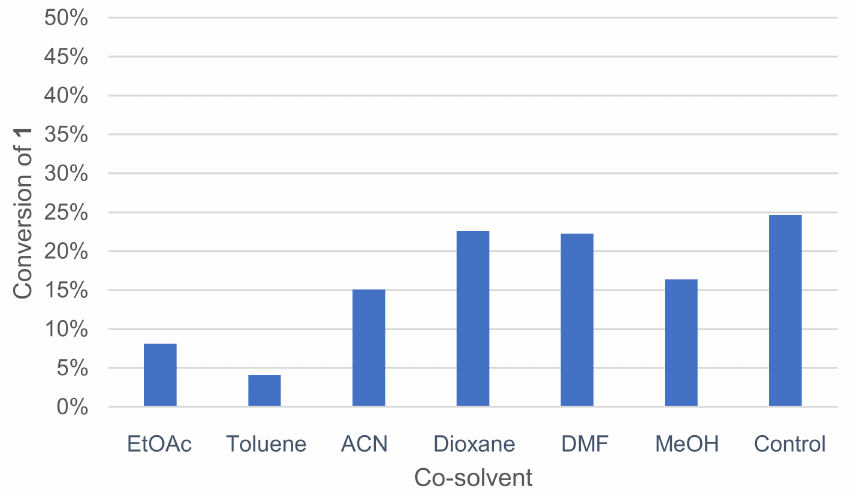
Figure 4. Effect of co-solvents on the conversion of 1 in the laccase-catalyzed oxidation (LA 10% w/w , HOBt 20 mol%, acetate buffer pH5 0.25 M, co-solvent 50% v/v buffer , O 2 atmosphere, incubation for 24 h, 40 ◦ C, 200 rpm).